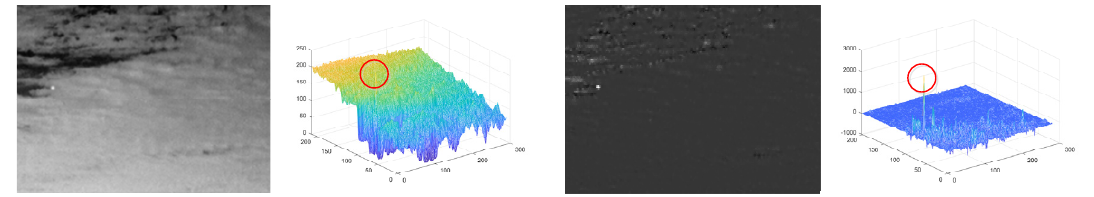
Figure 3. The original image and its MGCF